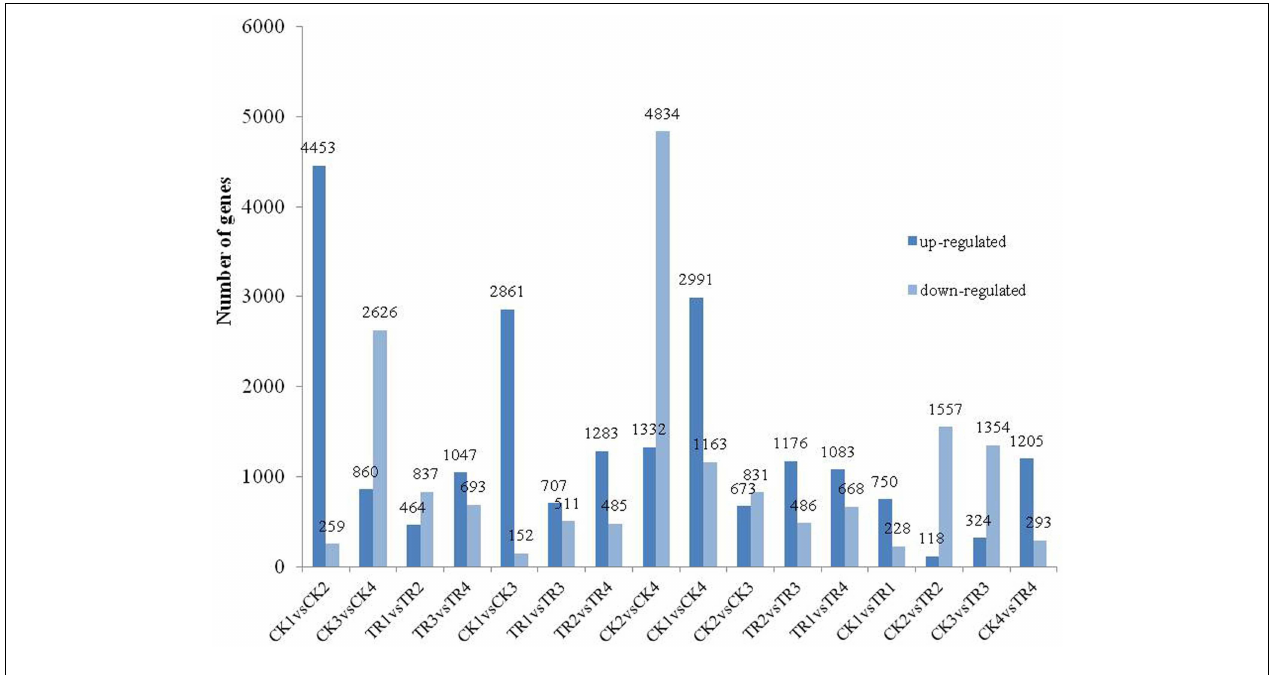
FIGURE 3 | Differentially expressed genes in different comparisons.